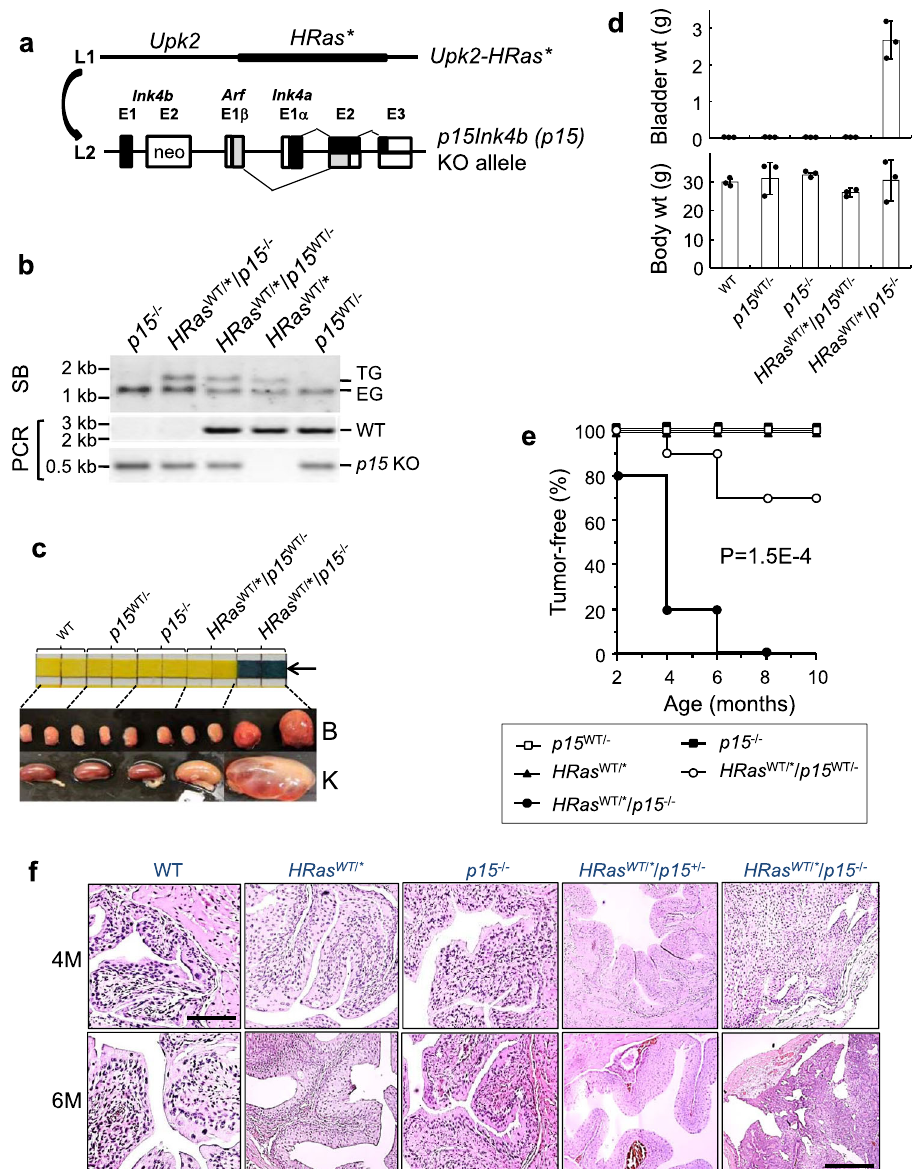
Fig. 1 Loss of p15 in mouse urothelial cells expressing oncogenic HRas triggers early-onset and highly penetrant urothelial carcinomas that strongly resemble low-grade, papillary, non-muscle-invasive bladder cancer in humans. a Mouse breeding scheme. Transgenic mice in which oncogenic HRas expression was under the control of murine Upk2 promoter (abbreviated as HRas WT/* mice) was crossed and backcrossed to p15Ink4b knockout ( p15 − / − ) mice in which exon 2 of the gene was replaced by a neo gene, which ablates p15 expression 53 . b Representative genotypes from one litter of the aforementioned crosses. SB Southern blotting detecting the restriction enzyme-digested transgene fragment (TG) of Upk2-HRas , and endogenous Upk2 fragment (EG); and PCR detecting the wild type (WT) and the p15 knockout (KO) allele. Genotyping was performed on every mouse with highly reproducible results, and cumulatively n > 50/genotype. Source data are provided as a Source Data fi le. c Urine dipstick test of hematuria (upper panel; only the blood- testing row is shown) and gross anatomy of bladder (B) and kidney (K) (lower panel) of 4-month-old mice (2 mice/genotype shown). Color change to dark blue (arrow) indicates hematuria. Note the highly enlarged renal pelvis in the HRas WT/* / p15 − / − mice. The kidney of the HRas WT/* /p15 WT/ − mouse was slightly bigger but lacked hydronephrosis upon sectioning. d Bladder and body weights (wt) of mice sacri fi ced at 6 months of age (3 mice/genotype). Data are presented as mean ±SD. e Tumor-free rate for genotypes indicated in the box (10 mice/time point/genotype). P value indicated ( P = 1.5E − 4) was for comparison between HRas WT/* /p15 WT/ − mice and HRas WT/* /p15 − / − mice, using the Kaplan – Meier method followed by log-rank statistical test using software SPSS v17.0. f Representative H&E images of mouse bladders from the key genotypes at 4 and 6 months of age. n = 10/genotype/time point. All the panels are of the same magni fi cation with the bar in the upper-left panel equaling to 100 μ m, except the lower right panel (scale bar = 500 μ